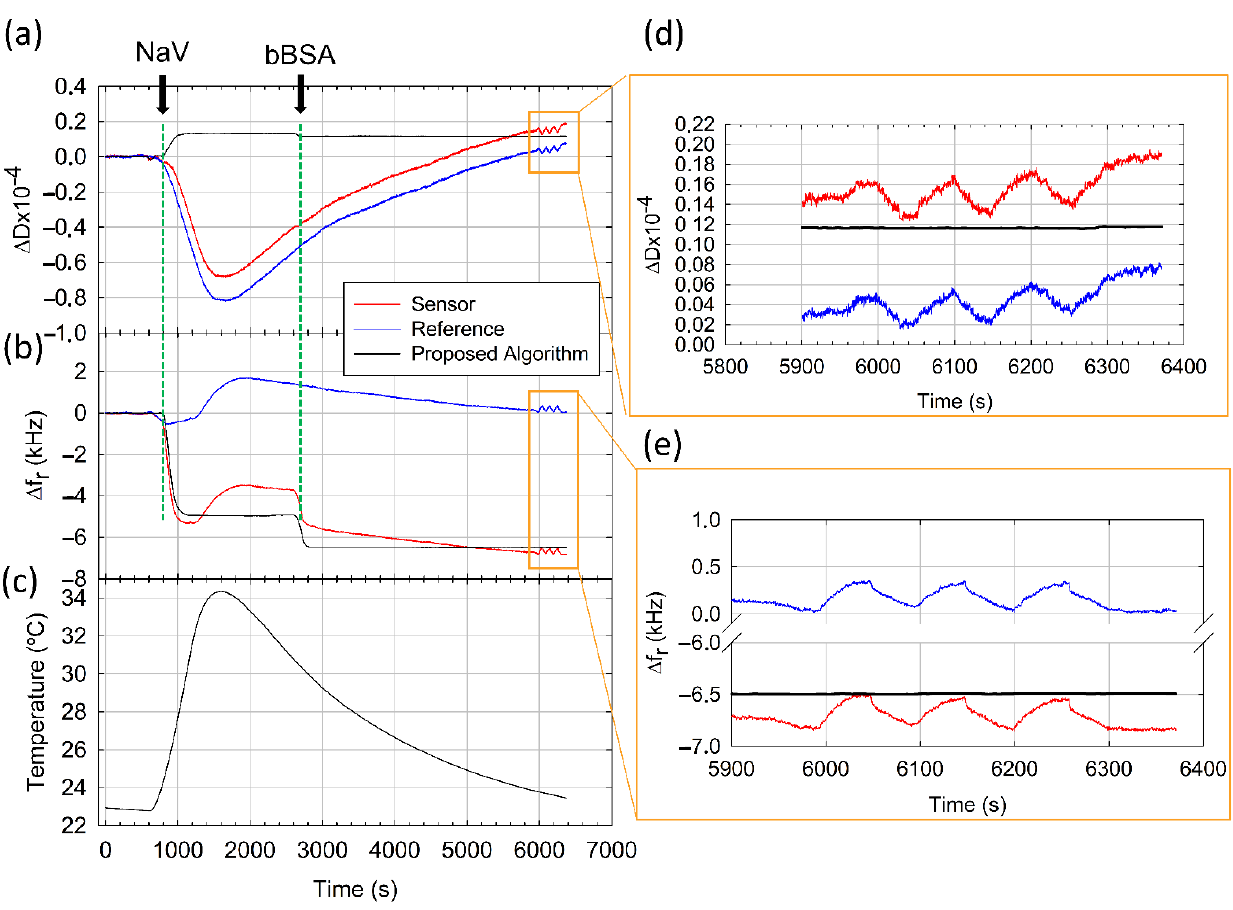
Figure 5. Dissipation ( a ) and resonance frequency ( b ) shifts monitored for sensor (red trace), reference (blue trace) and the algorithm result (black trace) under conditions of changing temperature and flow rate. ( c ) Temperature time evolution configured to increase from 23 °C to 34 °C and back to 23 °C. Detail of the effect of flow rate variation in dissipation ( d ) and resonance frequency ( e ) shifts.